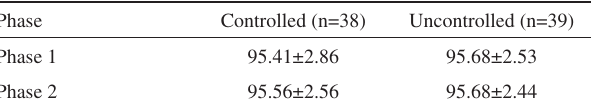
Table 2. Health-related quality of life scores obtained using Bulpitt and Fletcher’s Specific Questionnaire for Hyperten- sive patients of the two treatment groups across both phases of this